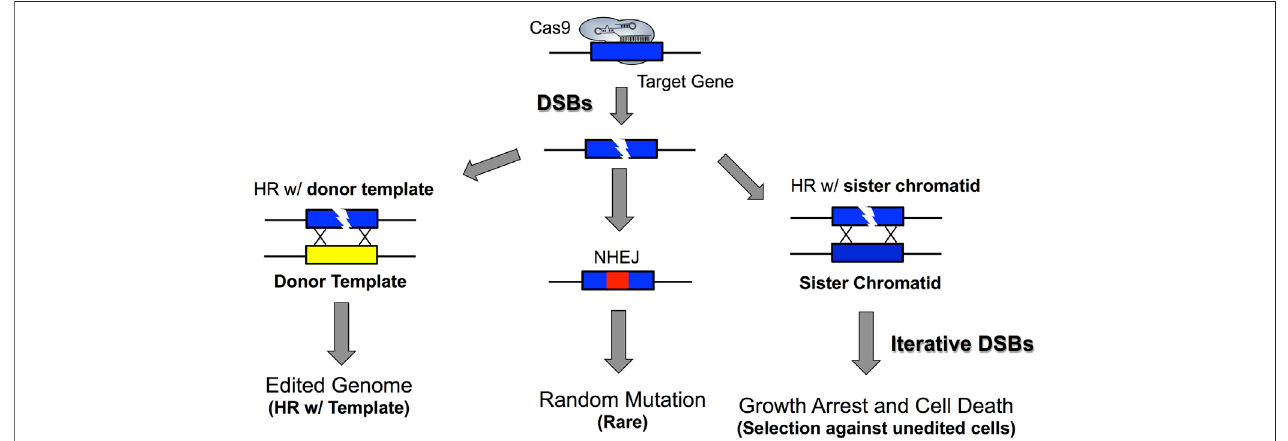
FIGURE2| DSBrepairinS.cerevisiaeallowsformarker-freegenomeediting. Thehighef fi ciencyofhomologousrecombination inyeastallowshomologousdonor templates such as oligonucleotides or PCR products to be ef fi ciently incorporated into yeast cells. However, if cells escape Cas9 editing or editing occurs outside the PAMmotiforsgRNAtargetingspace,itispossiblethatCas9couldcontinuallytargetDNAanditerativelyformDSBsintheyeastgenome.Additionally,thiscouldleadtoa low frequency of non-homologous end joining repair of DSBs, which generates random indels at the Cas9 target site. Importantly, the toxicity of Cas9-induced DSBs allows for strong selection against unedited cells because unedited cells typically die, especially if many DSBs are being generated under continual and repeated Cas9 targeting. This highlights a critical parameter for marker-free genome editing in yeast in that desired genomic edits can be obtained by selecting for yeast cells that actively express Cas9 and sgRNA. Moreover, this demonstrates how PAM inactivating mutations, which abrogate CRISPR/Cas9 targeting can be used to minimize the potential detrimental effects associated with excessive and iterative generation of DSBs while also allowing for correct genomic edits to still be enriched for under selective pressure (see key references: Garst et al., 2017; Gorter de Vries et al., 2019; Laughery and Wyrick,